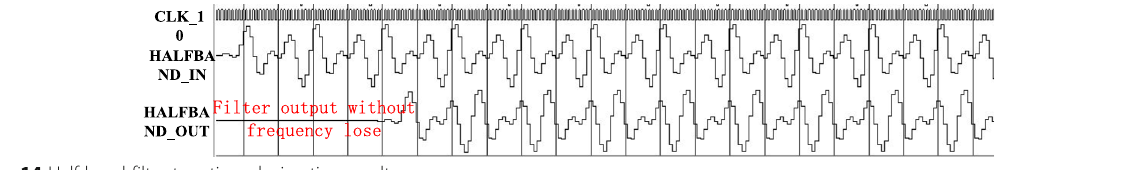
Fig. 14 Half-band filter two-time decimation